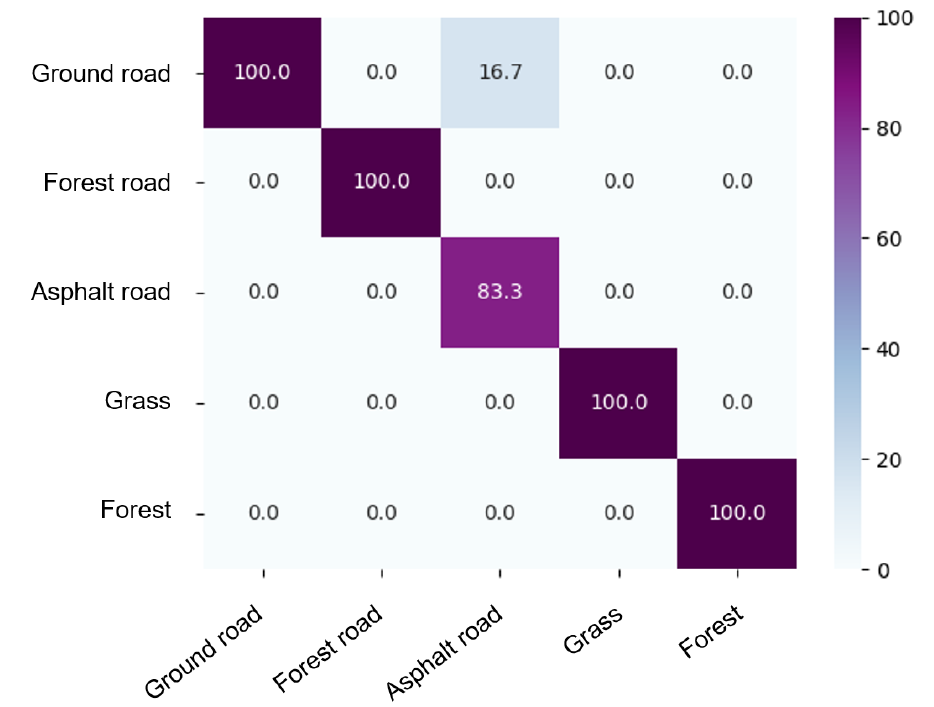
Figure 8. Classification diagram.